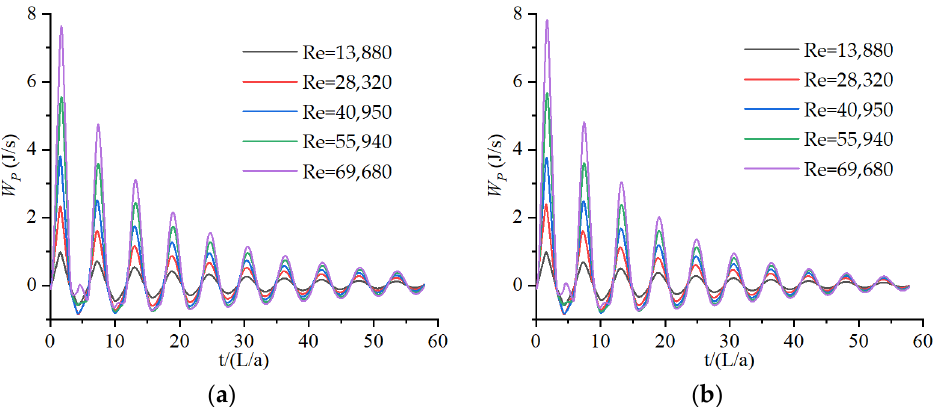
Figure 8. Viscoelastic work, W P , at different Re values in the critical region: ( a ) 1D model; ( b ) 2D